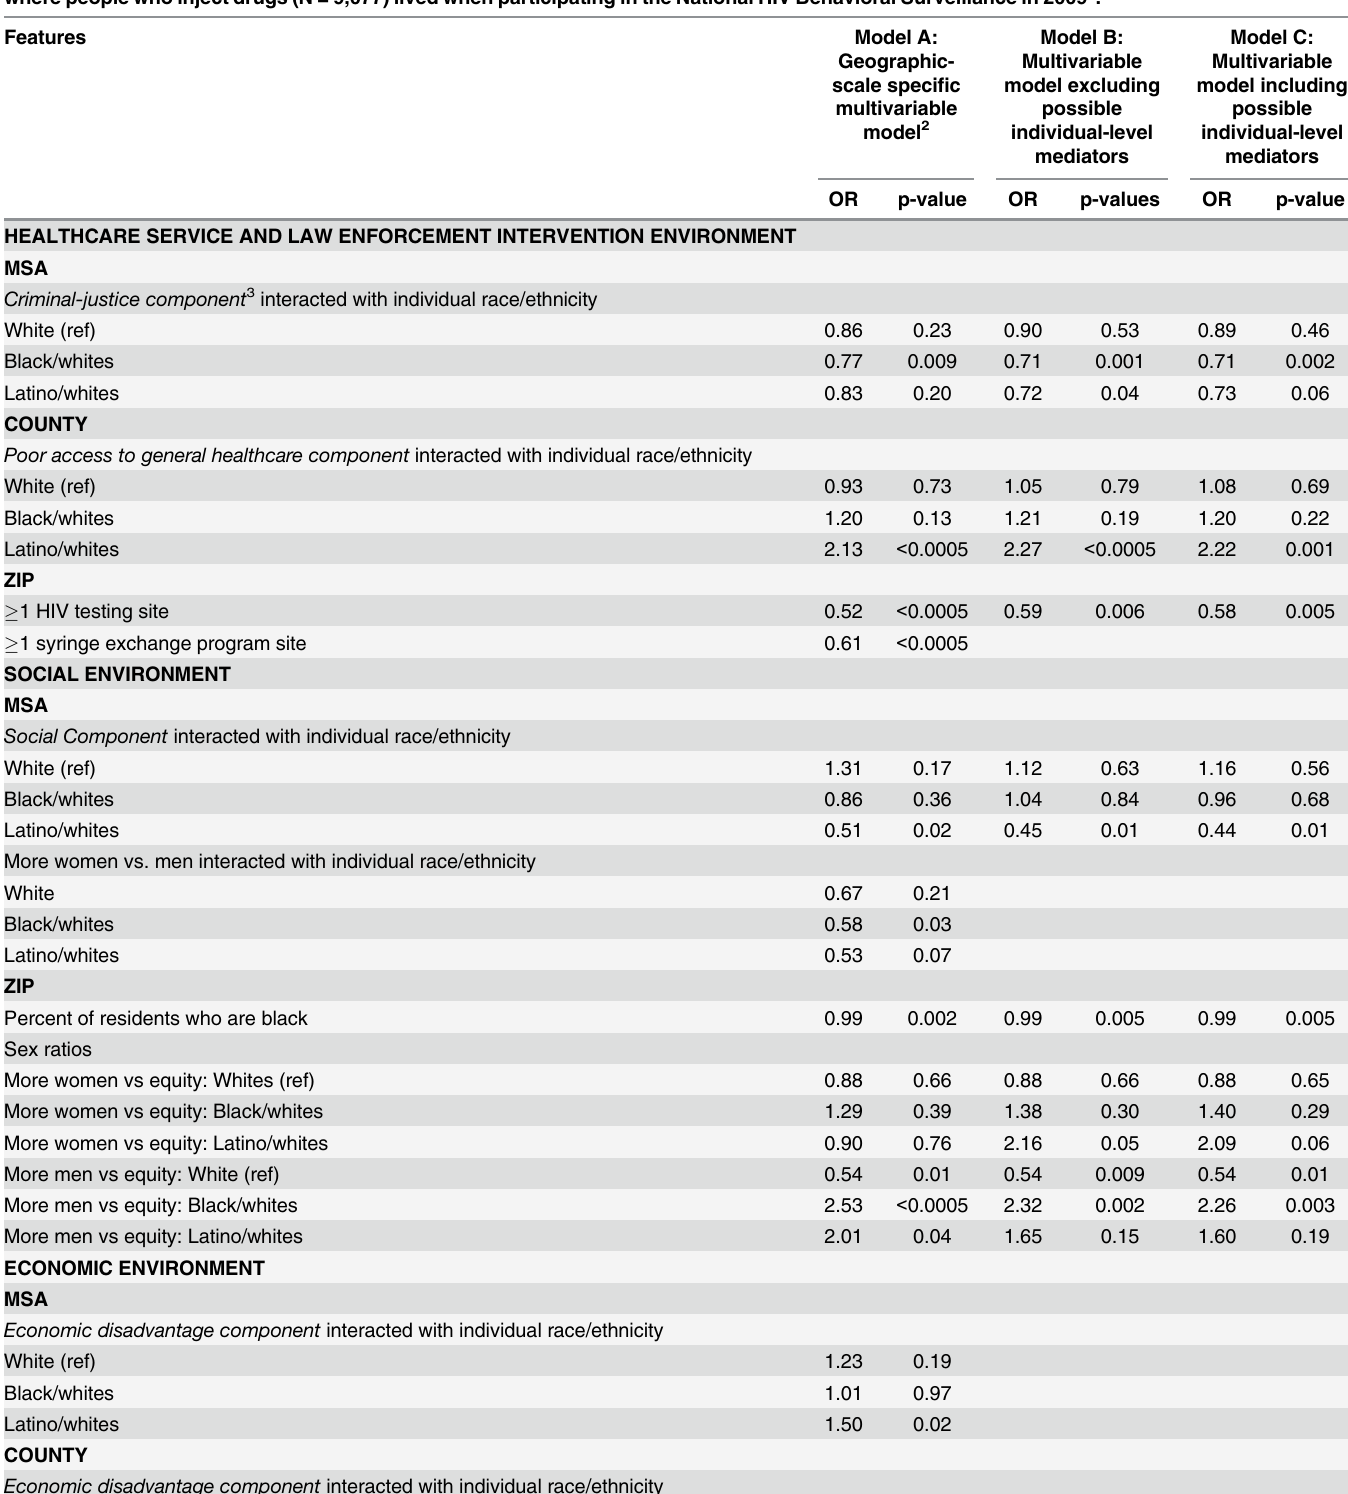
Table 7. Multivariable hierarchical generalized linear models regressing the odds of HIV negative status on characteristics of the environments where people who inject drugs (N = 9,077) lived when participating in the National HIV Behavioral Surveillance in 2009 1 .